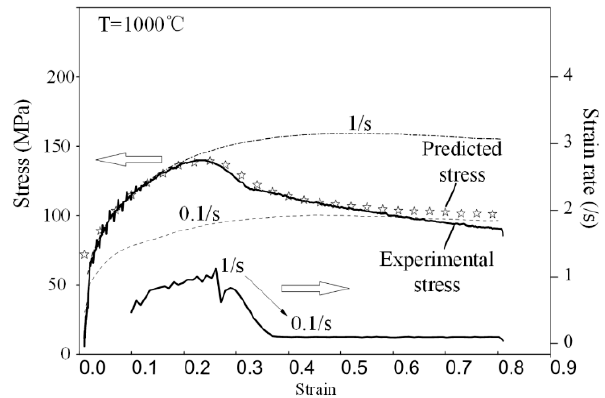
Figure 8. The measured strain rate, the predicted flow stress, and the measured flow stress of a variable strain rate compression.